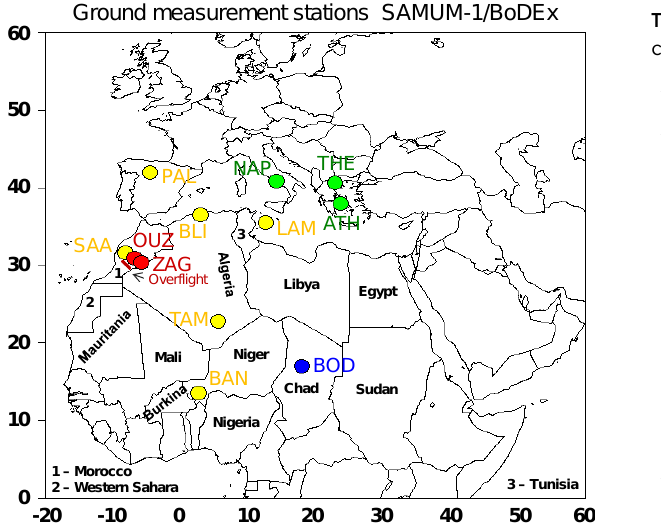
Fig. 1. Overview of all ground measurement stations within the model simulation domain used in this paper. Red dots are the SAMUM-1 field sites Ouarzazate (OUZ) and Zagora (ZAG), yel- low dots are AERONET stations, the blue dot is the BoDEx field site Chicha, and the green spots are EARLINET lidar stations. The Falcon overflight path just south of Ouarzazate and Zagora is shown in red.